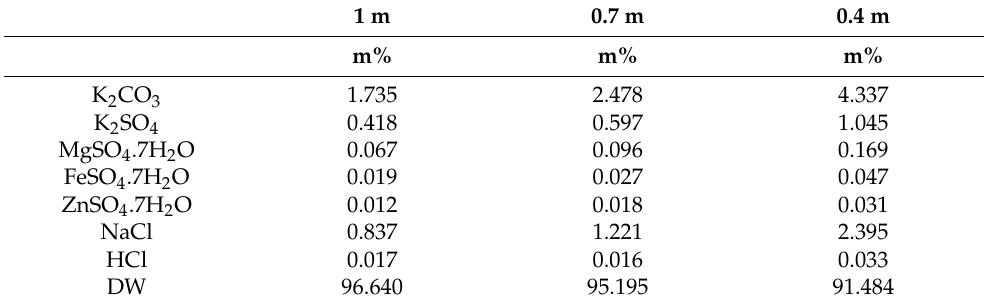
Table A4. Composition of the salt solutions that were added to the growth media that simulate the growing medium of a continuous system after 175 days of cultivation in a 1 m/0.7 m/0.4 m deep tank. DW = demi-water.